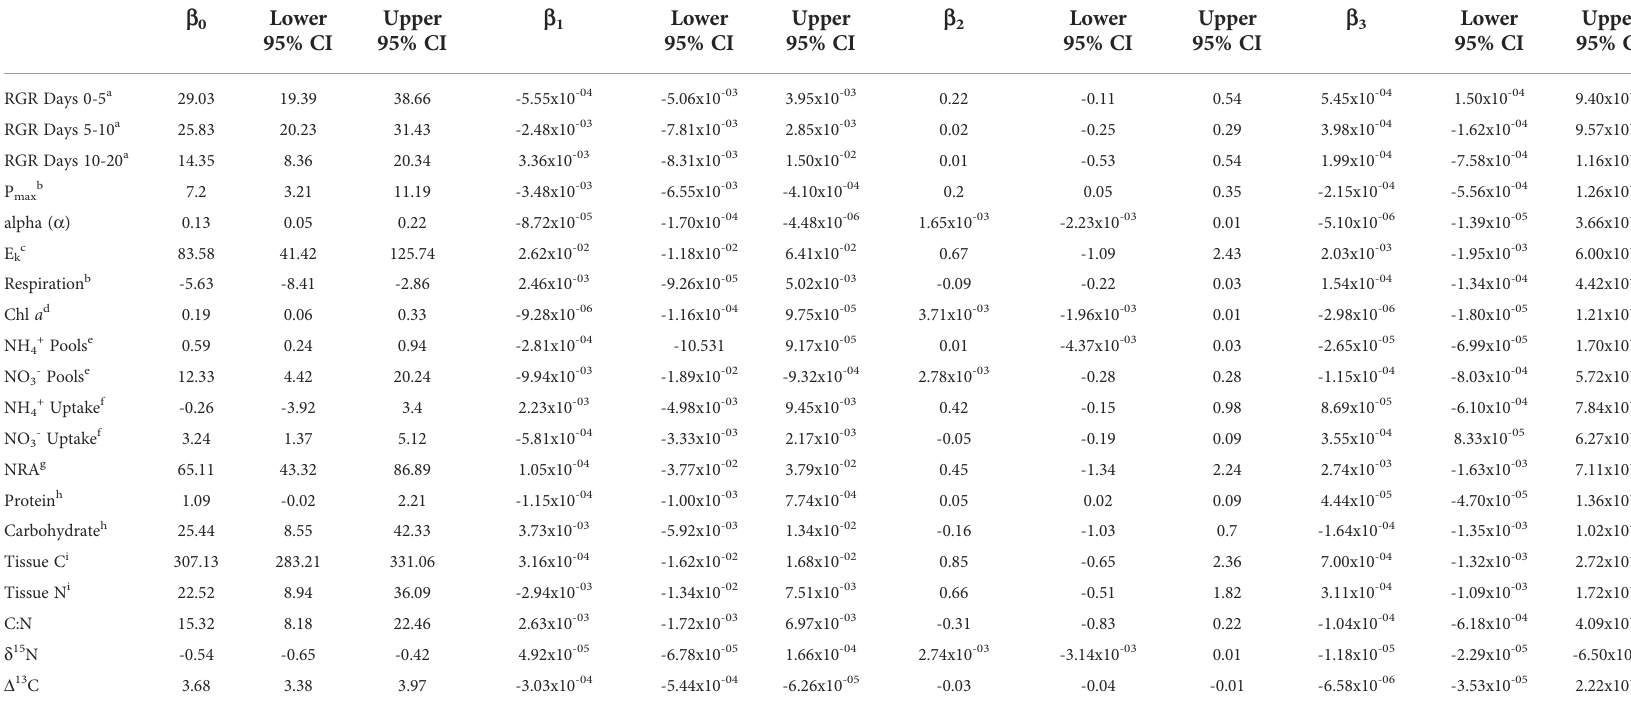
TABLE 2 Weighted, model-averaged estimates of conventional regression coef fi cients and 95% con fi dence interval (CI) for each experimental